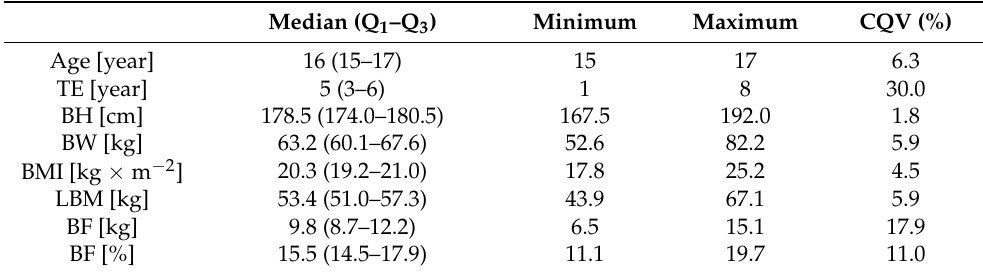
Table 1. Main characteristics of the studied cyclists.